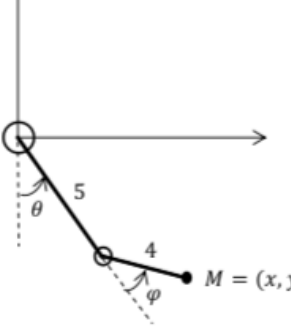
Figure 9. Articulated arm.